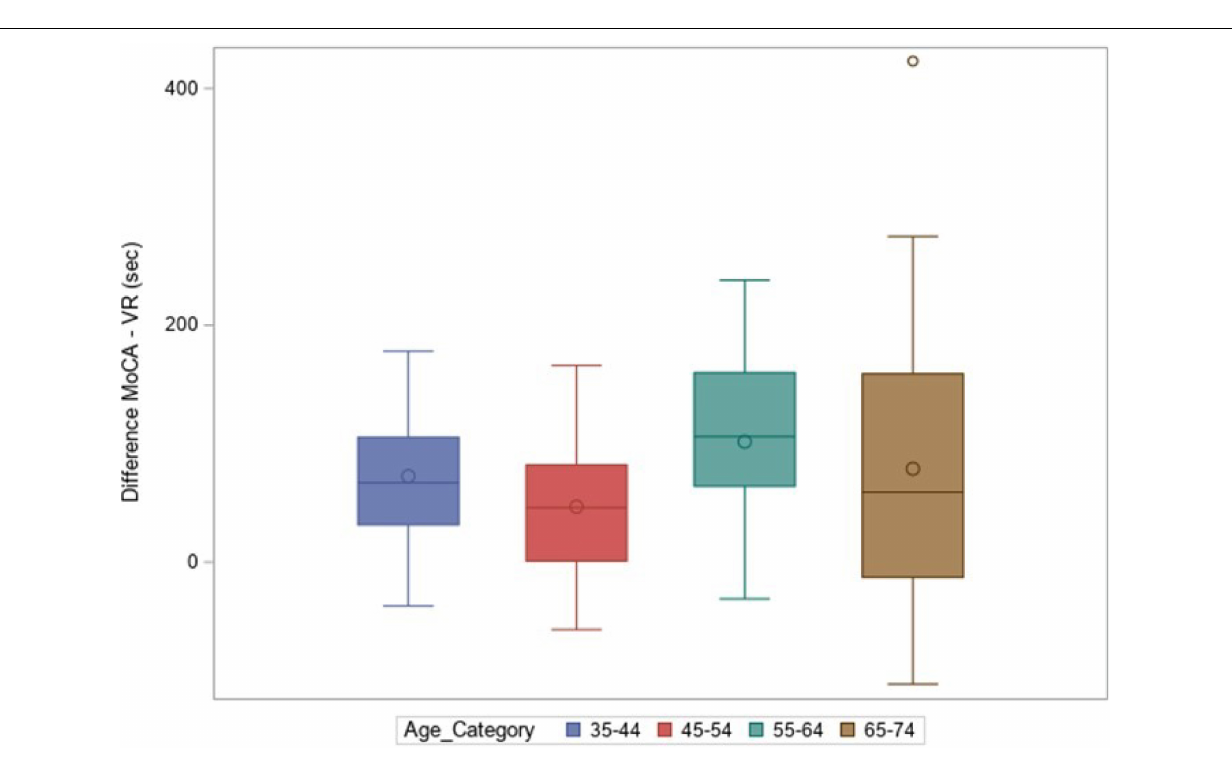
Frontiers in Aging Neuroscience |